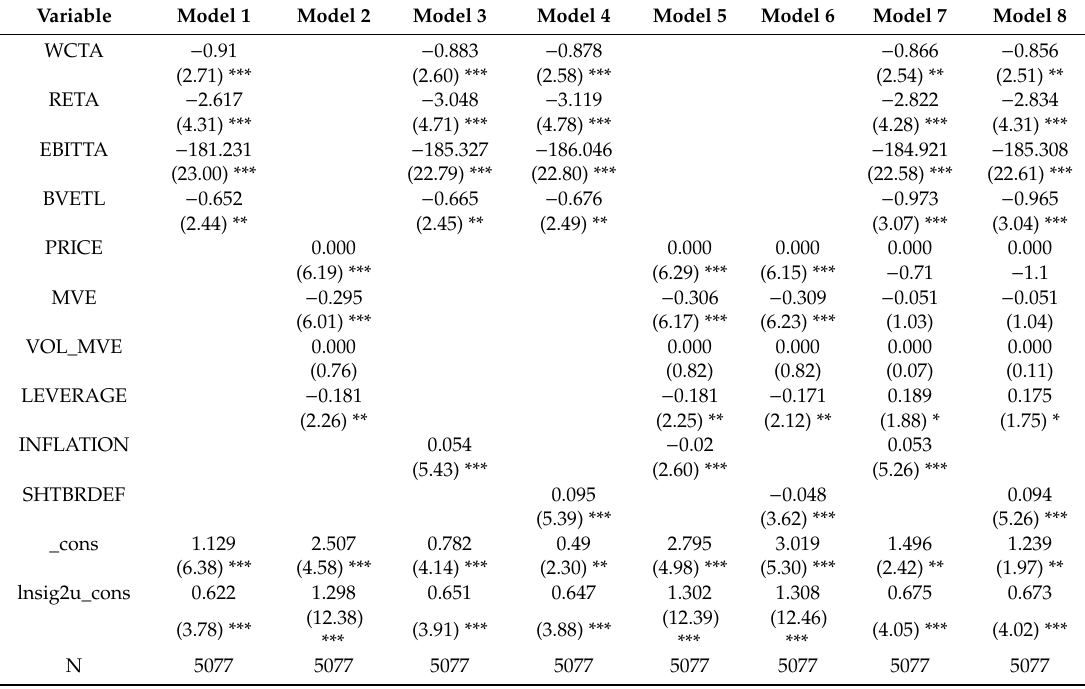
Table 6. Financial distress of Vietnamese listed firms post-GFC (2010–2017).